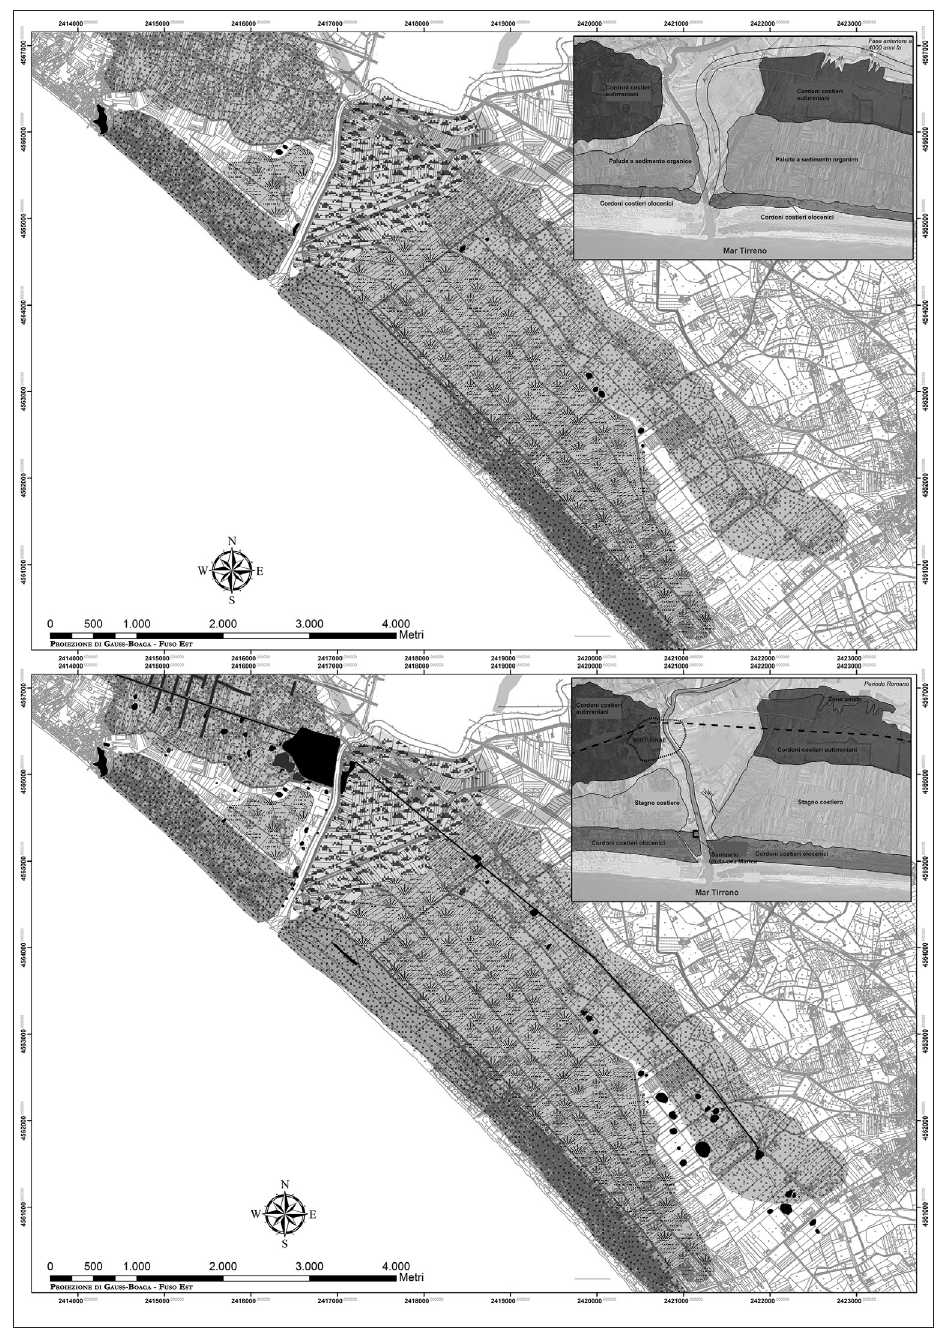
Figure 4: Archaeologic map of the coast near Minturnae (Pre Roman and Roman periods– Ferrari 2016: fig. 66,